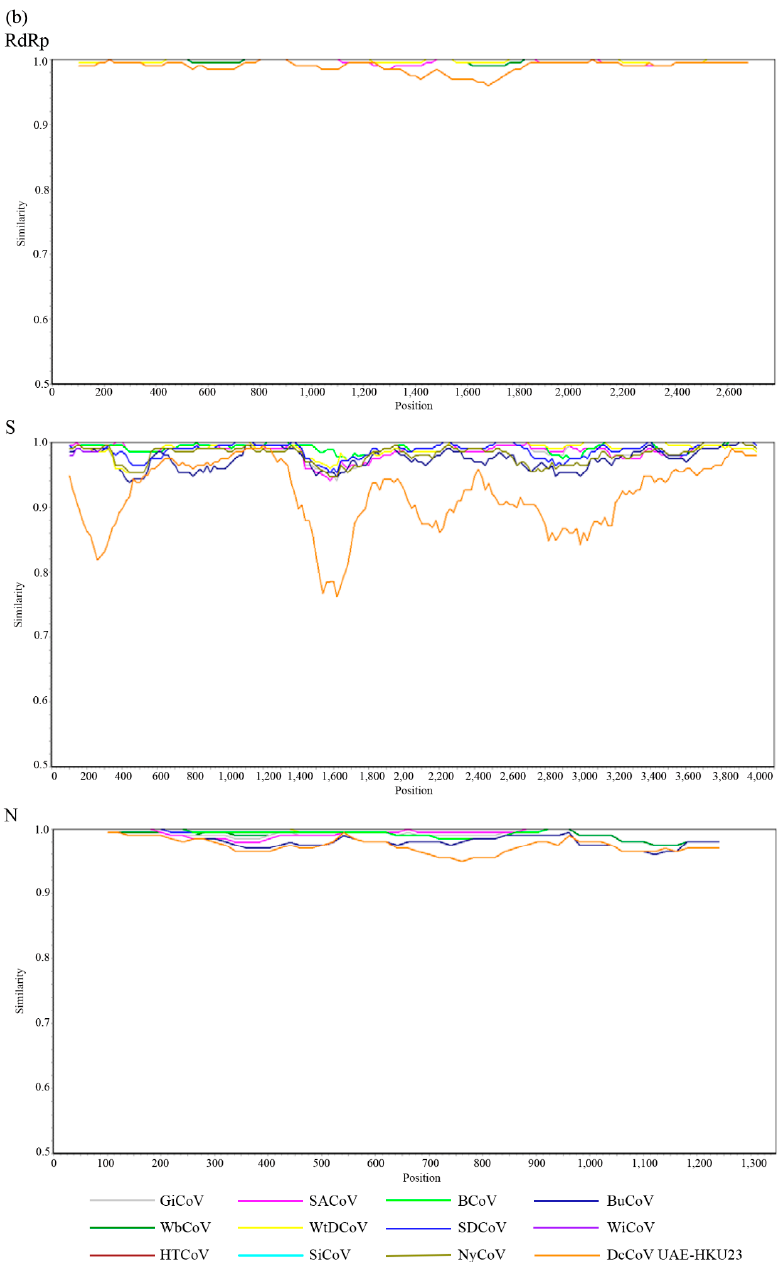
Figure 6. ( a ) Scatter plot of the corresponding analysis (CA) using relative synonymous codon usage (RSCU) of the RdRp, S, and N genes of members of Betacoronavirus 1 and RbCoV HKU14. Different coronaviruses are indicated in different colored markers. The group of bovine coronavirus-like viruses is circled; ( b ) SimPlot analysis of complete RdRp, S, and N genes of DcCoV UAE-HKU23, alpaca CoV, BCoV and other wild ruminant CoVs. Each point plotted is the percent genetic distance within a sliding window of 200 nt wide, centered on the position plotted, with a step size of 20 nt. Each curve represents a comparison of the sequence data of DcCoV UAE-HKU23, BCoV, and other wild ruminant CoV strains to the reference sequence data of alpaca CoV. Alpaca CoV, alpaca coronavirus; BCoV, bovine coronavirus; BuCoV, Bubalus bubalis coronavirus; CRCoV, canine respiratory coronavirus; DcCoV, dromedary camel coronavirus, ECoV, equine coronavirus; GiCoV, giraffe coronavirus; HCoV-OC43, human coronavirus OC43; HTCoV, Himalayan tahr coronavirus; NyCoV, nyala coronavirus; PHEV, porcine hemagglutinating encephalomyelitis virus; RbCoV, rabbit coronavirus; SACoV, sable antelope coronavirus; SDCoV, sambar deer coronavirus; SiCoV, sitatunga coronavirus; WbCoV, waterbuck coronavirus; WiCoV, wisent coronavirus; WtDCoV, white-tailed deer coronavirus.